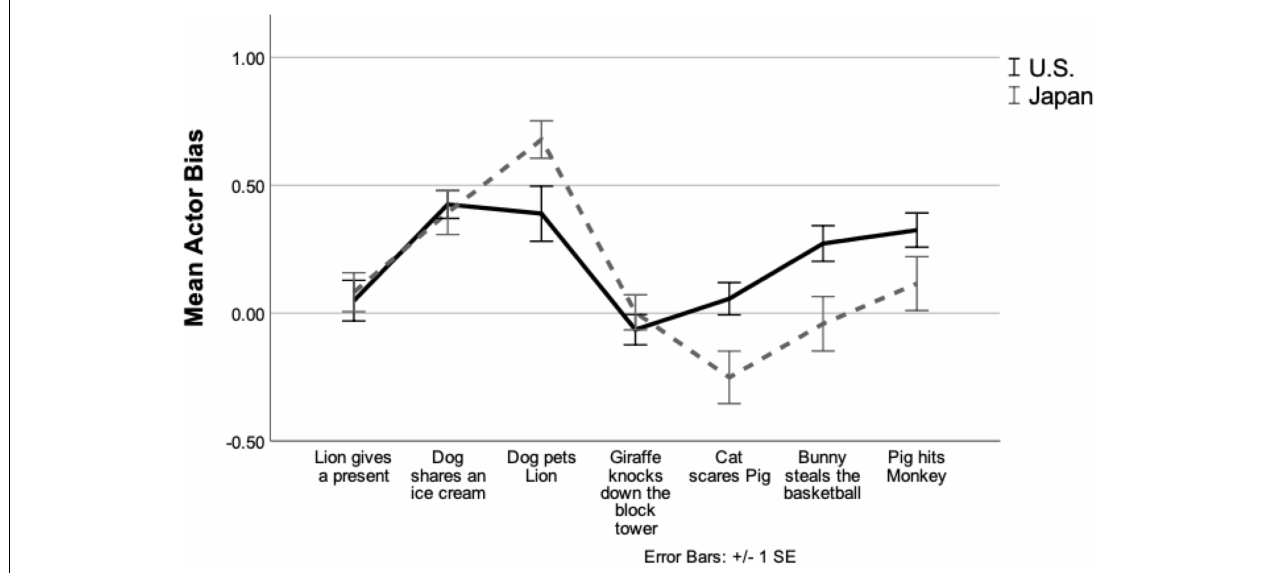
FIGURE 2 | Line graph of mean actor bias of each puppet show. The mean actor bias (the proportion of the actor talk over the proportion of the recipient talk) is shown for each show. The positive number indicates more reference was given to the actor of the scene, the negative number indicates more reference was given to the recipient of the scene, and zero indicates both characters were discussed equally. The United States results are displayed in a solid black line and Japanese results are displayed in a dotted gray line. The first three scenes are positive social events and the last four scenes are negative social events. Error bars were set as ± 1